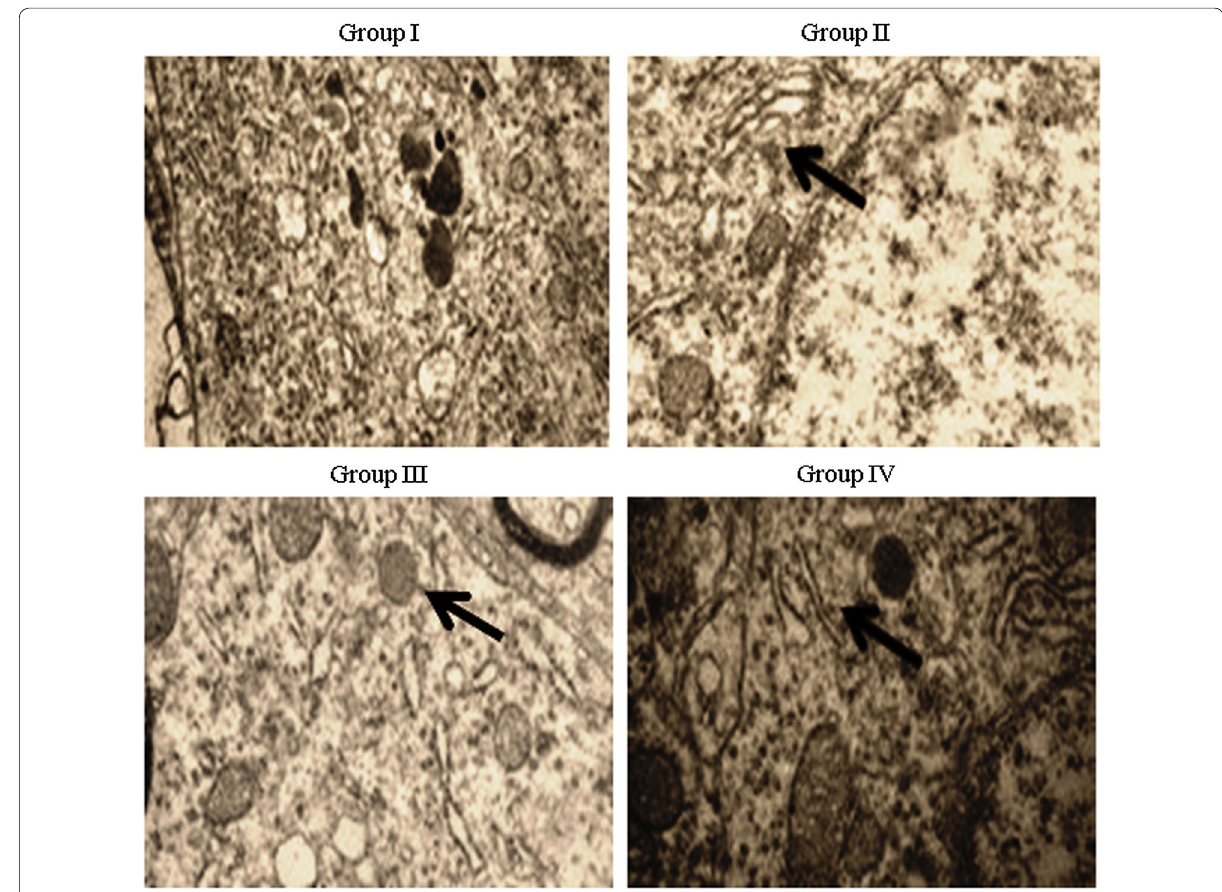
Fig. 7 Effect of E. hirta extract on the cellular architecture of lungs in neonatal asthmatic rats. Lung sections were stained and evaluated under a microscope. Magnification, 40 and n 6 × =